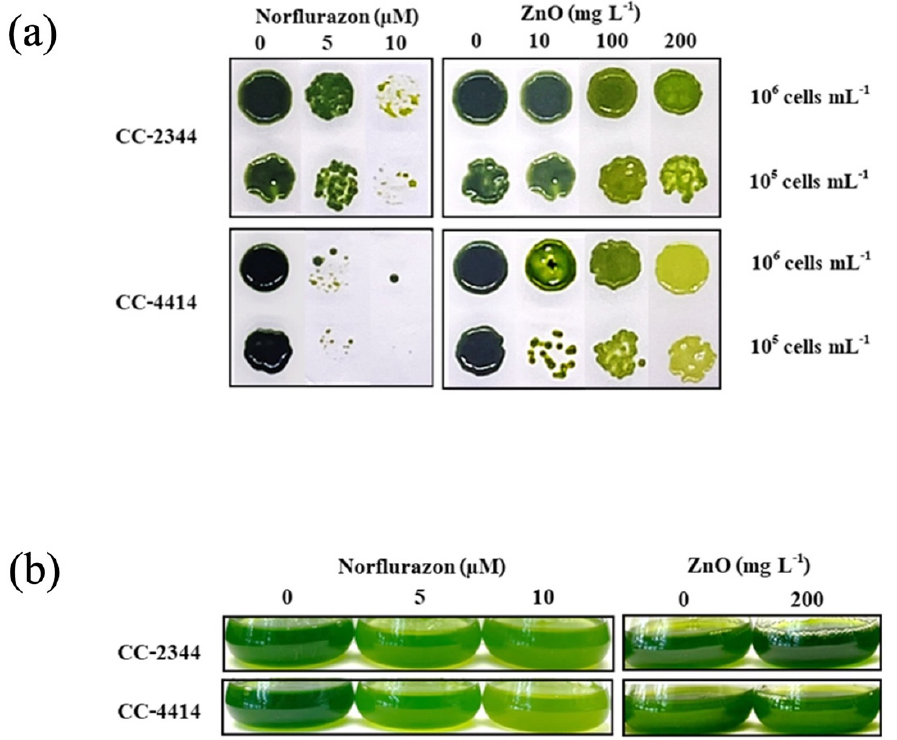
Figure 1. Growth of C. reiinhardtii CC-2344 and CC-4414 cells with and without norflurazon and ZnO NPs on plates ( a ) and in liquid cultures ( b ). Exponential phase cultures were diluted to the indicated cell density, and a 3 µL aliquot was spotted onto plates with the indicated chemical at different concentrations. Liquid cultures were diluted to a density of 1 × 10 6 cells mL − 1 and the chemical at the indicated concentration was added. Photographs were taken after 96 h.